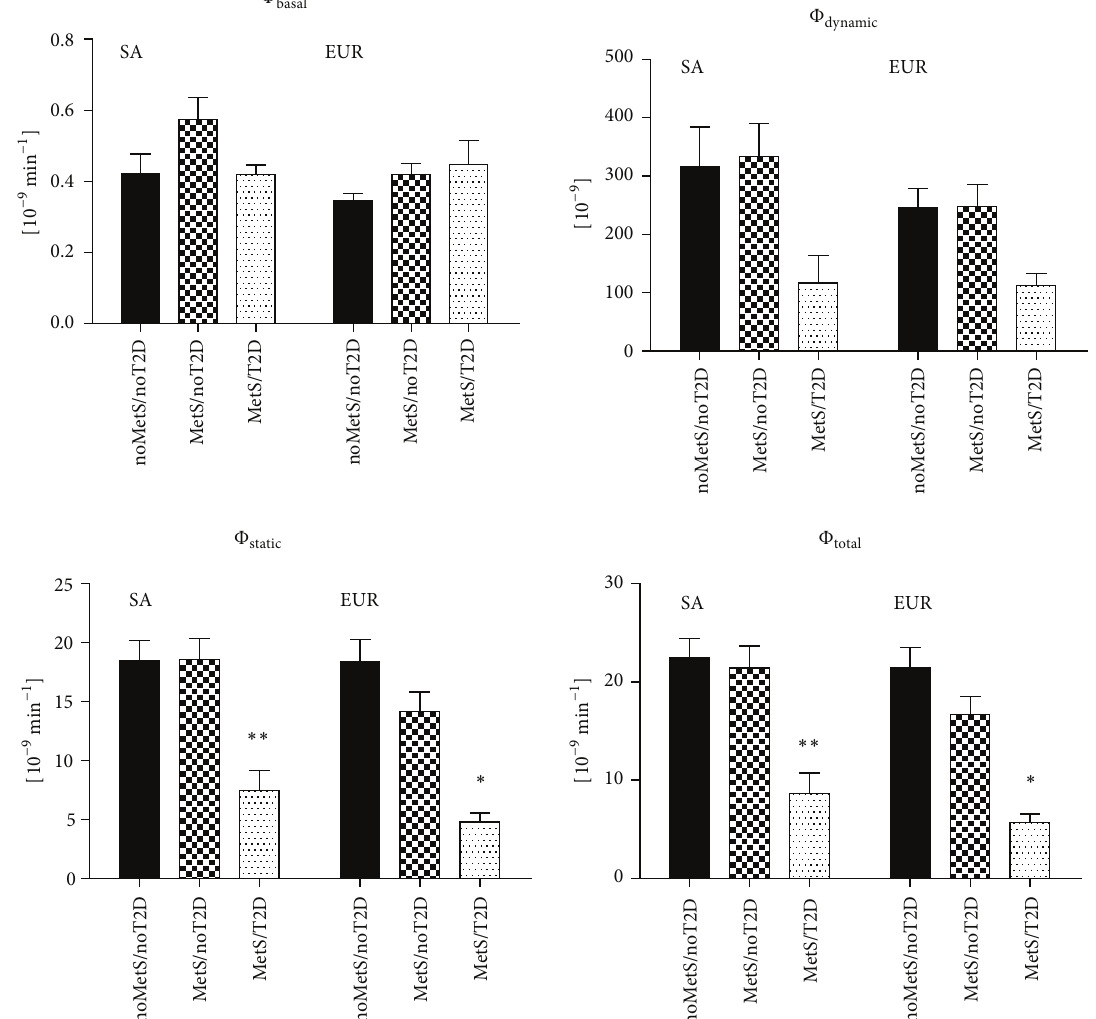
Figure 2: 𝛽 -cell insulin responsivity indices in South Asian (SA) and European (EUR) subgroups. ∗ indicates a statistically significant difference in comparison with the noMetS/noT2D subgroup; ∗∗ indicates a statistically significant difference between the MetS/noT2D and MetS/T2D